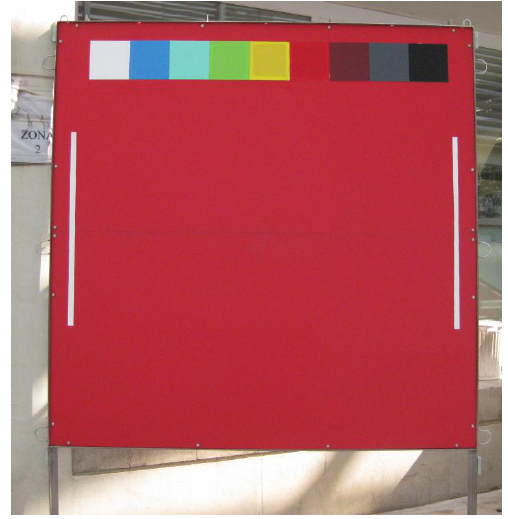
Figure 2. The methacrylate red panel used for automated RGB colorimetric calibration of images taken by OBSEA camera at different times of the day. White vertical lines (100 cm length) can be used as general size bars for fish length determination in absence of more precise measuring methods ( i.e. ,